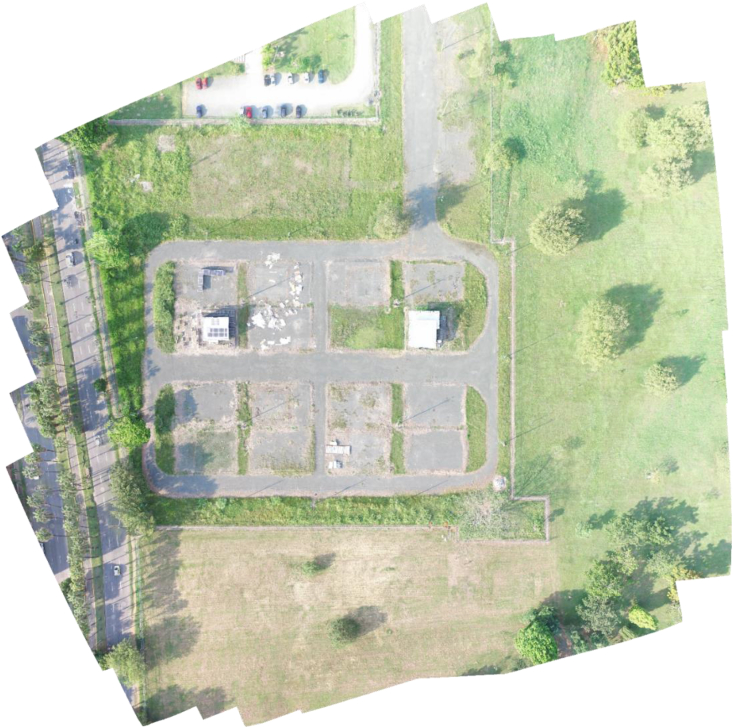
Visible orthoimage.